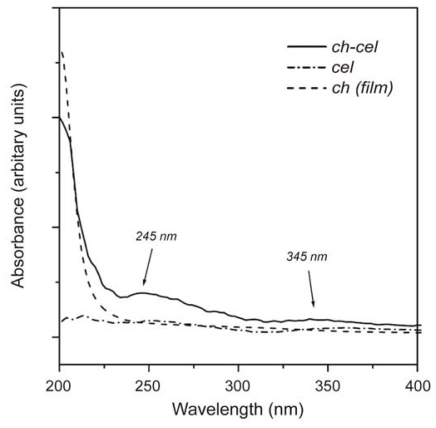
UV–Vis spectrum of a pure chitosan (ch) film measured in transmission mode, and diffuse reflectance UV–Vis spectra of untreated cellulose (cel), and cellulose treated with 1% chitosan (ch–cel). Reprinted from European Polymer Journal 42, 2006, Urreaga, J.M., de la Orden, M.U., Chemical interactions and yellowing in chitosan-treated cellulose, 2606–2616, Copyright (2010), with permission from Elsevier [107].